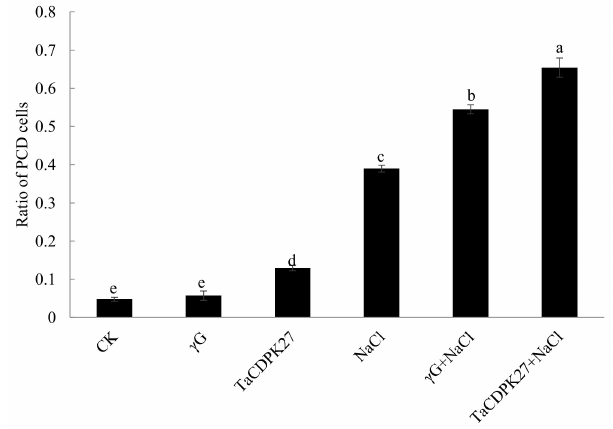
Figure 7. The effect of silencing TaCDPK27 on PCD level in leaves of wheat seedlings under NaCl treatment. CK was from wild-type wheat seedlings, γ G was from BSMV-VIGS-GFP-inoculated wheat seedlings, and TaCDPK27 was from BSMV-VIGS-TaCDPK27-inoculated wheat seedlings. Bars with different letters are significantly different at p < 0.05.